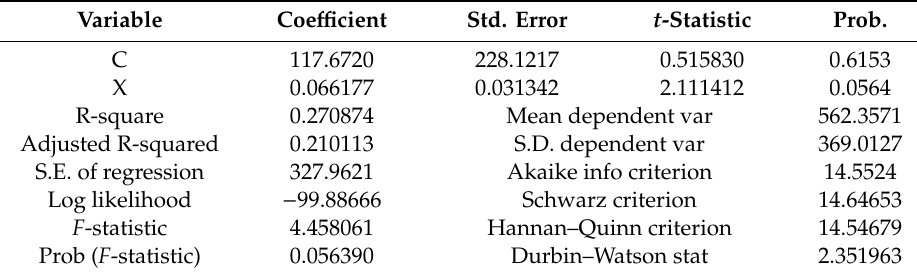
Table 4. Results of Alpha rice.